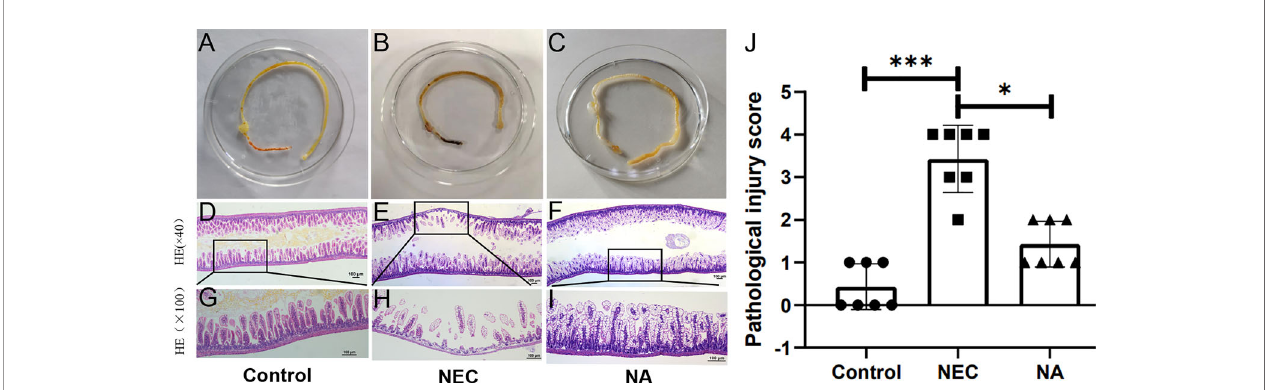
FIGURE 2 | (A – C) Macroscopic morphological analyses of the intestines of newborn mice in the three groups. (D – I) Images of HE staining by light microscopy. The histological damage in the terminal ilea in the three groups, control group (D, G) , NEC group (E, H) , NA group (F, I) . Black rectangle indicates a representative area, with a zoomed-in image. Magni fi cation: ×40, ×100. scale bar = 100 m m. (J) Gut histopathological injury scores in the control, NEC and NA group mice. Numbers of samples: Con (n=7), NEC (n=7), and NA (n=7). Statistics: Kruskal-Wallis test (*p < 0.05; ***p < 0.001). Images of HE staining of each sample from the three groups are provided in Supplementary Figure 1